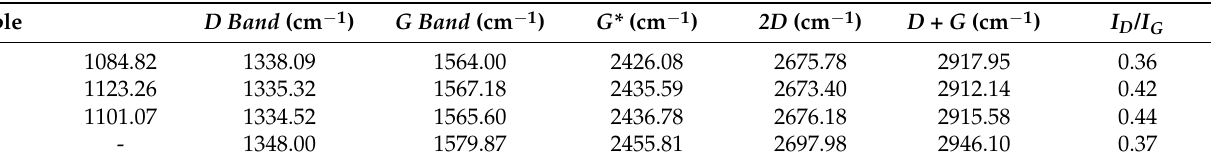
tangent fluctuation of sp 2 hybridization in carbon [56]. The D2 band is an indicator of the long-range graphite order due to the strong coupling between electrons and phonons [56]. Table 1. Raman shifts (cm − 1 ) of (A) MWCNT-COOH, (B) MWCNT-CONOHMe, (C) MWCNT- CONOHCOMe, and (D) MWCNT-CONOHCOPh.